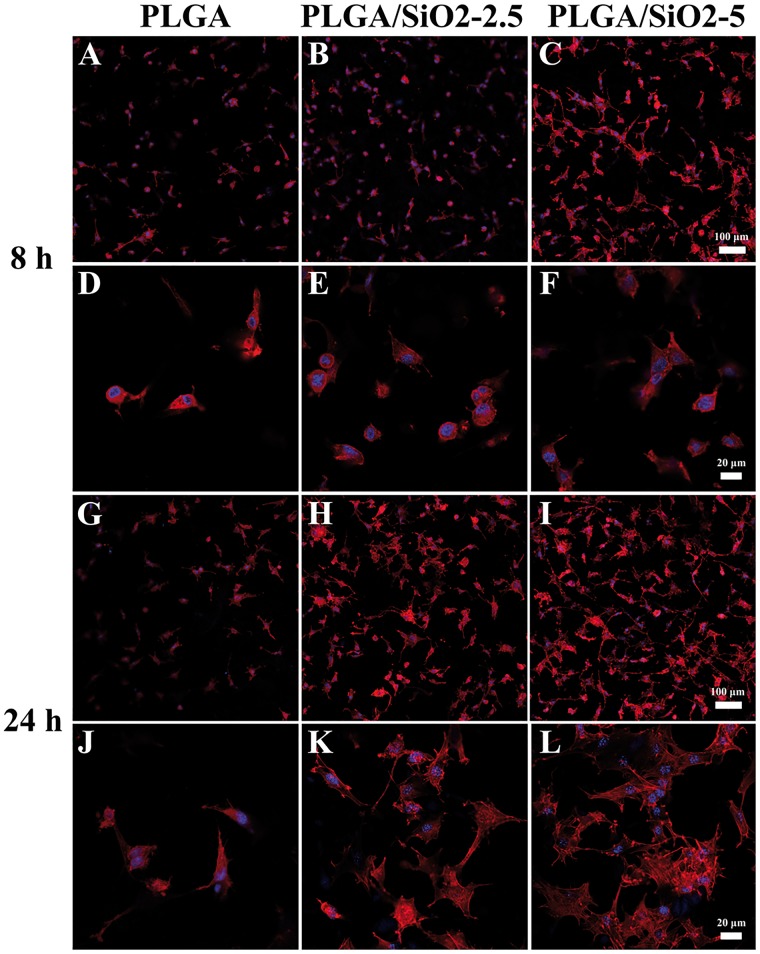
CLSM Images of SaOS-2 cells after 8 and 24 h of culture on PLGA, PLGA/SiO2-2.5 and PLGA/SiO2-5 fibers. F-actin was stained with phalloidine-TRITC (red) and cell nucleus was stained with DAPI (blue)